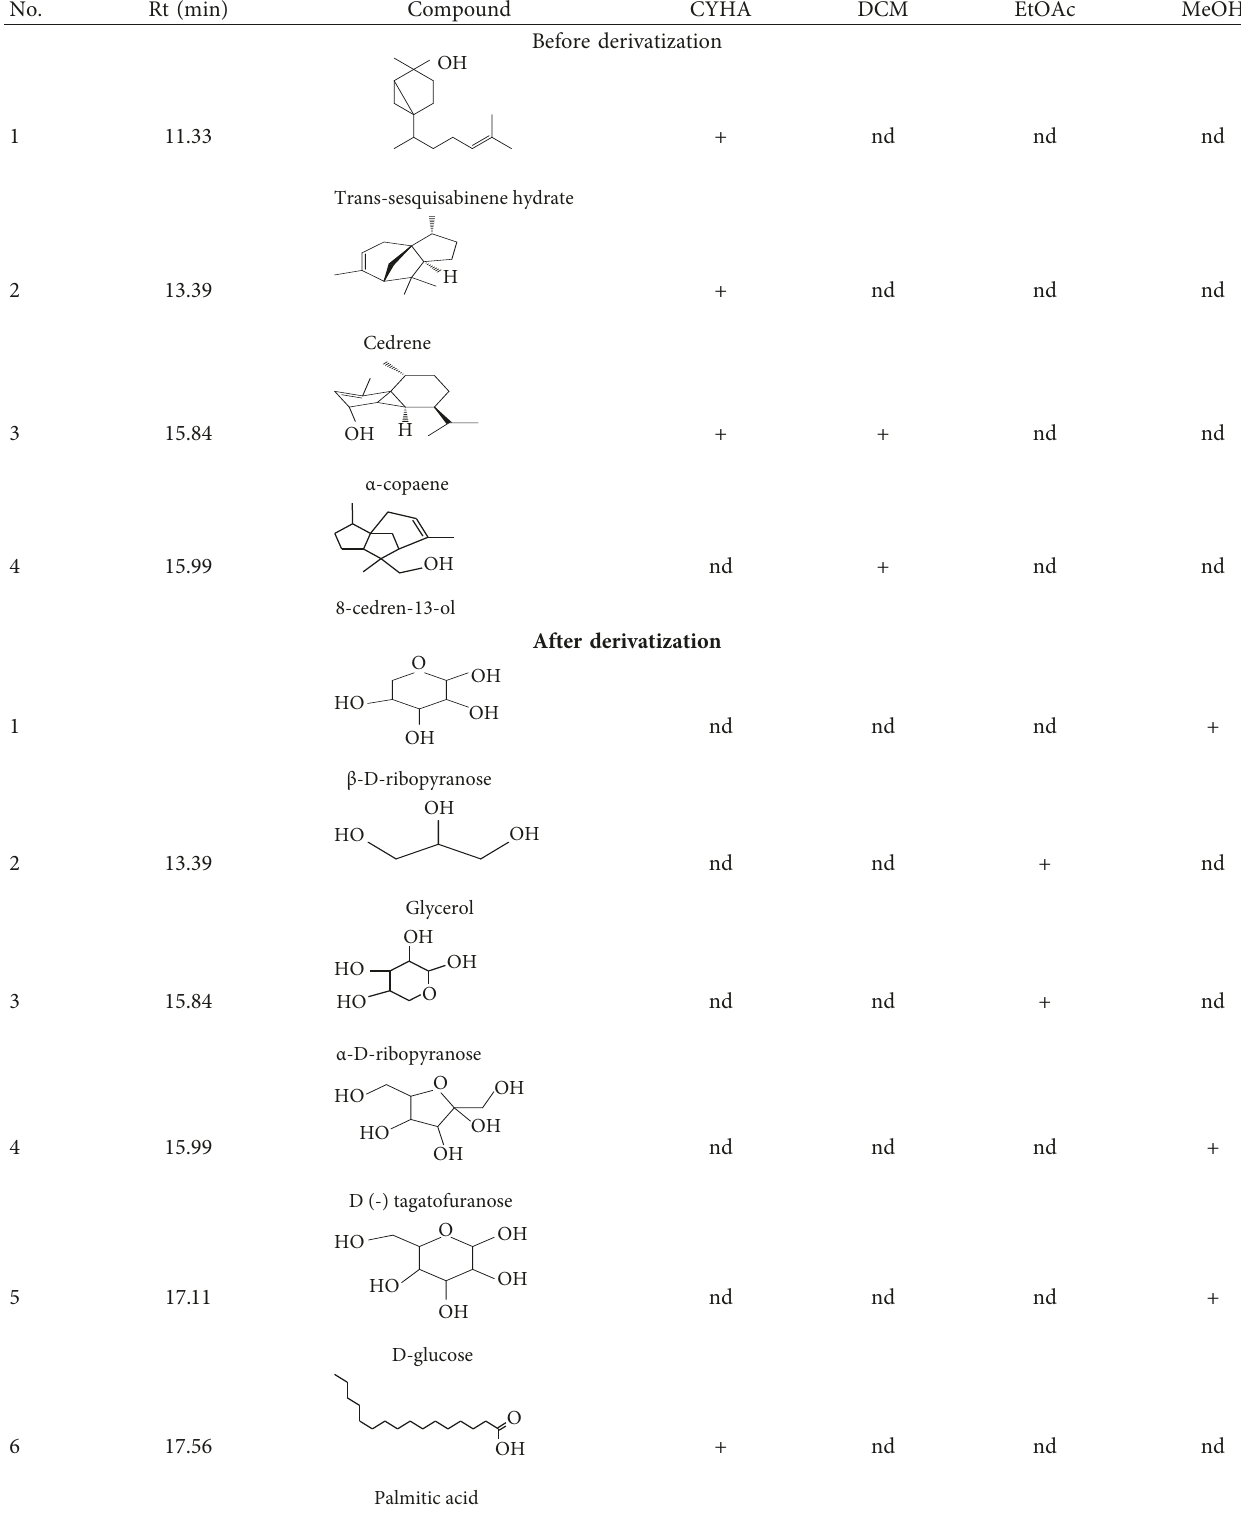
Table 3: GC-MS compounds detection and identification in different extracts of M. mabokeensis Aubr´ev before and after the derivatization. No. Rt (min) Compound CYHA DCM EtOAc MeOH Before derivatization